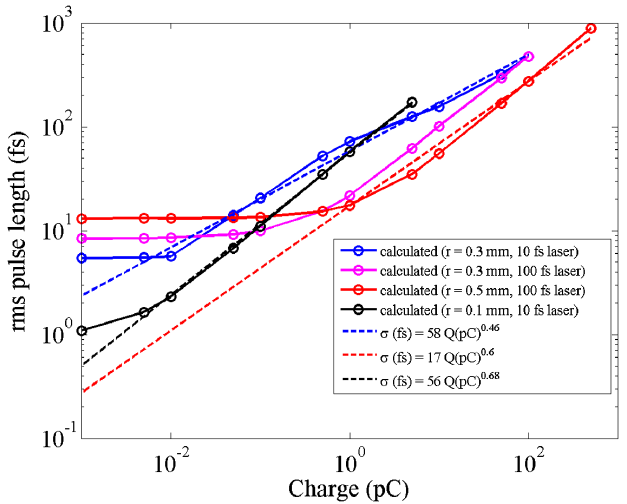
FIG. 18. Simulated bunch lengths 0.2 m from the cathode versus bunch charge. Also shown are power law fits to these results.